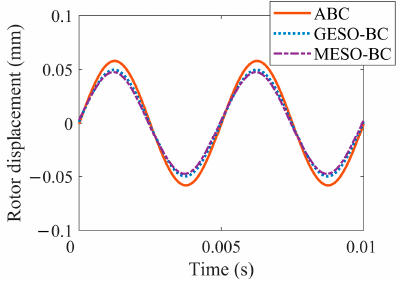
Figure 8. Response waveforms under 6 N sinusoidal disturbance simulations.